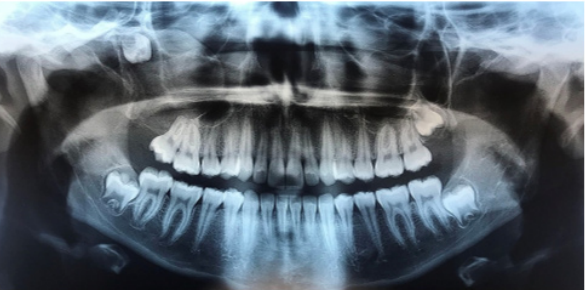
Figure 1. Preoperative panoramic radiograph showing an ectopic eruption of the right maxillary third molar in a superior position near pterygomaxillary fissure inside the right maxillary sinus and surrounded by well-defined hyperdense lesion obliterating the right maxillary sinus